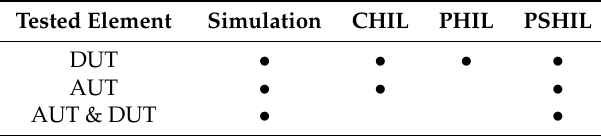
Table 1. Testing approaches for DUTs and AUTs. Tested Element